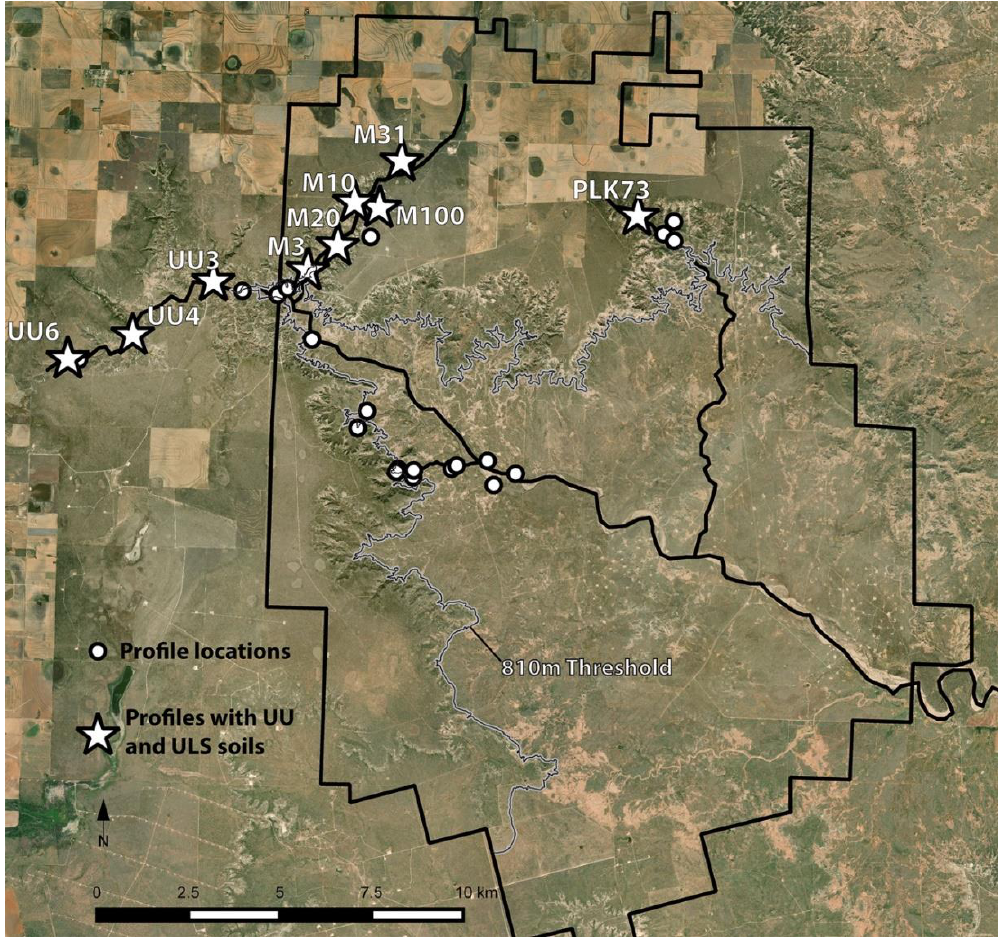
Figure 7. Location of soil profile localities from the current study and that of Murphy et al. (2014) in relation to the ~810 m threshold at the Post research area along the eastern escarpment into the westernmost Rolling Plains of Texas.